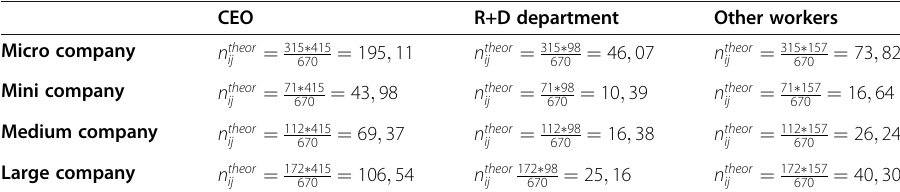
Table 3 n theor ij